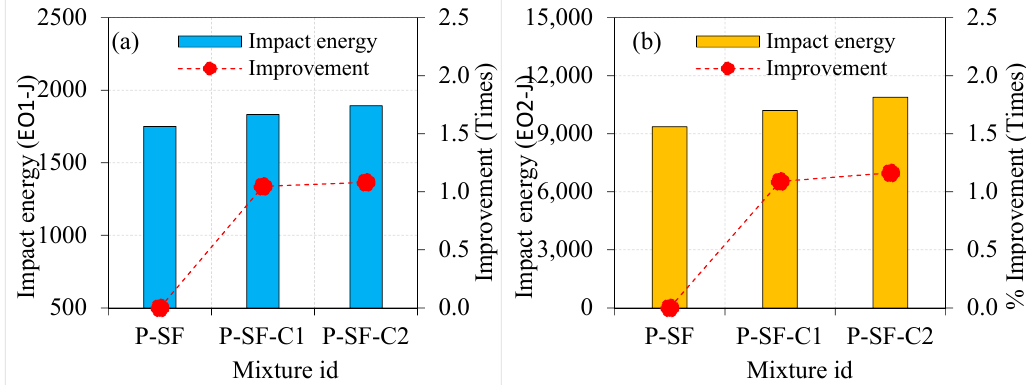
Figure 12. Effect of asphalt coating on impact strength of SF-based specimens ( a ) EO1 and ( b ) EO2.